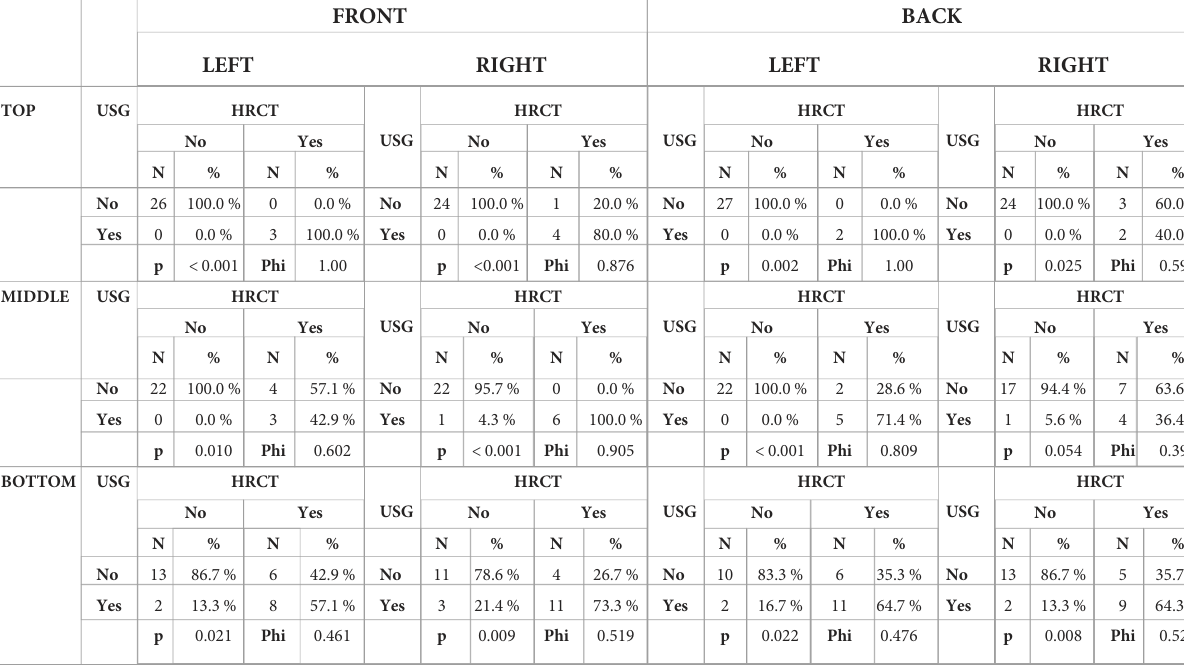
TABLE 2 Analysis of the frequency of fi brosis with the coef fi cient phi for the correlations between fi ndings detected in lung ultrasound and high- resolution computed tomography. FRONT BACK LEFT RIGHT LEFT